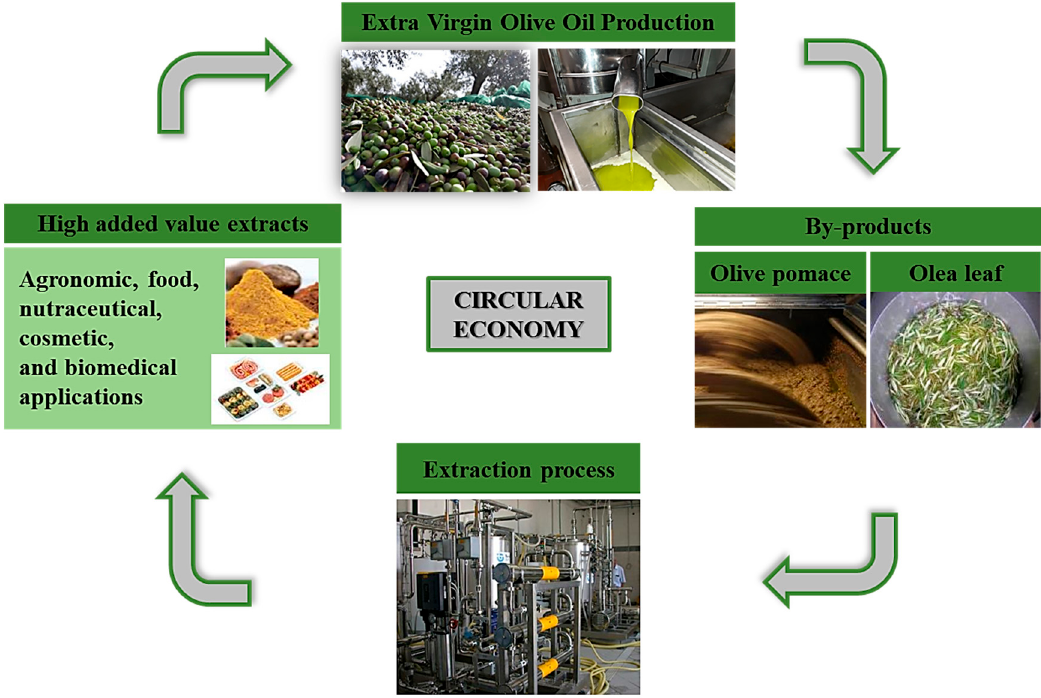
Figure 3. Circular economy platform based on green technologies, for the recovery of active molecules from olive leaf and processing by-products, useful in the food, nutraceutical, cosmetic, and biomedical fields.